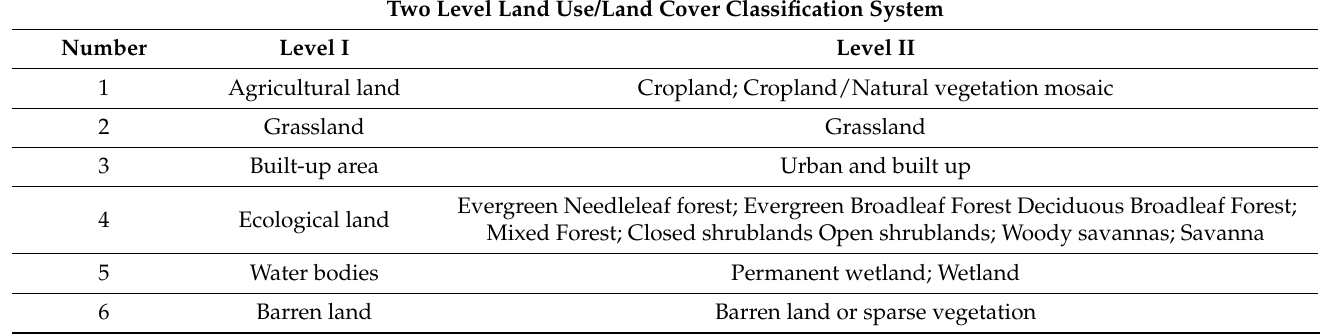
Table 3. Classification method of land use